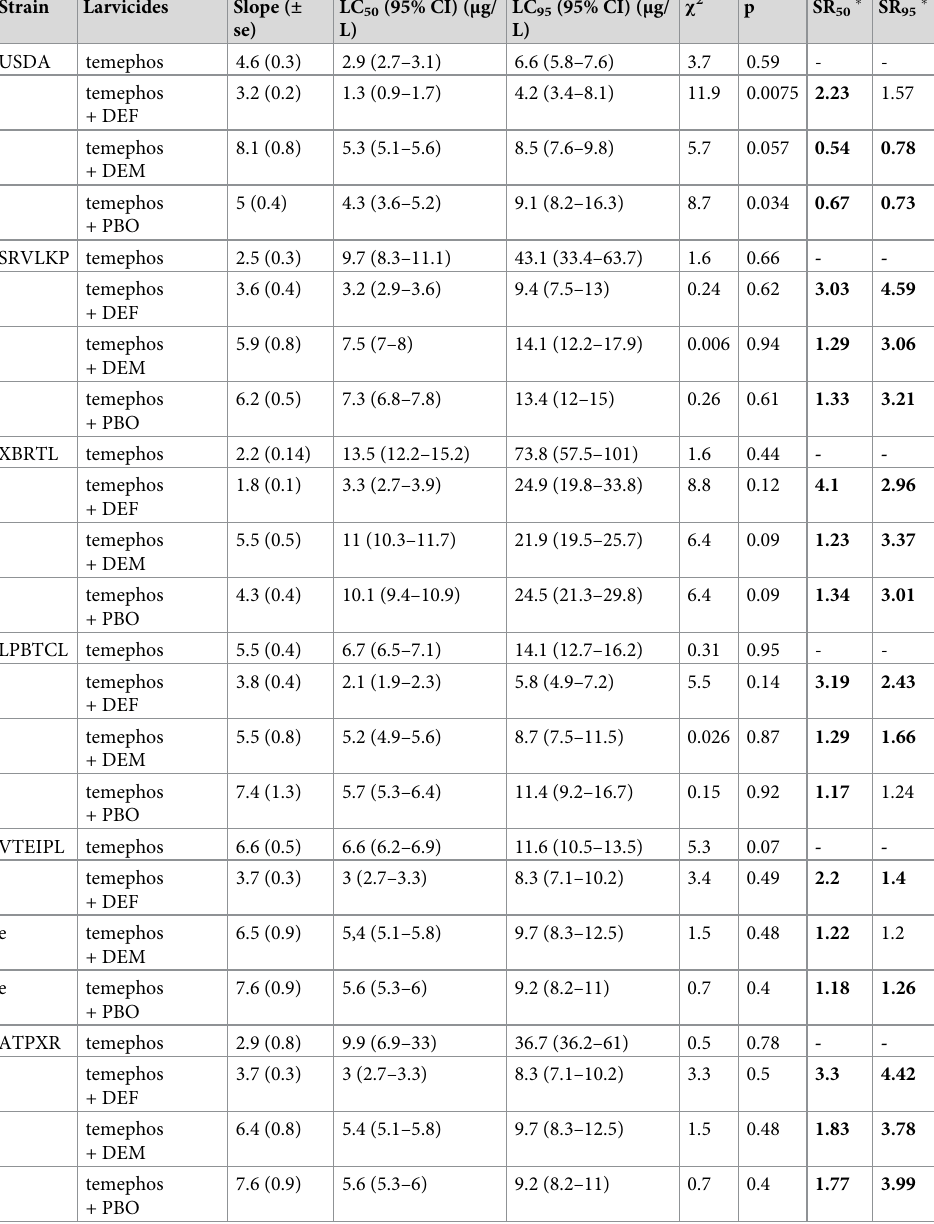
Table 3. Insecticidal activity of temephos against Aedes aegypti larvae (reference strain and field populations) with and without inhibitors. Strain